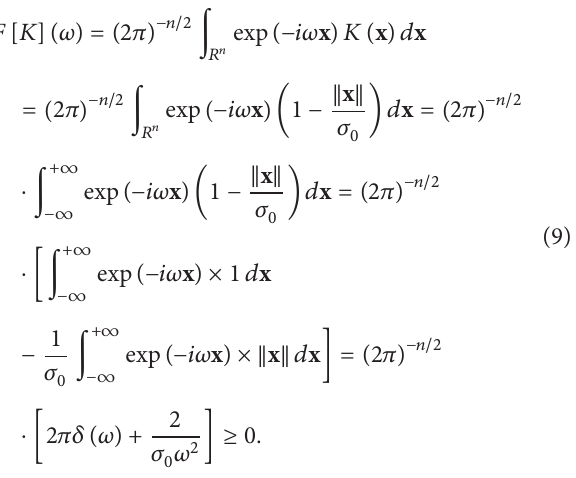
Figure 1: The graph of 𝐾 RBF ( x , 0) and 𝐾 mac ( x ,0) , where 𝜎 = 1,2 .